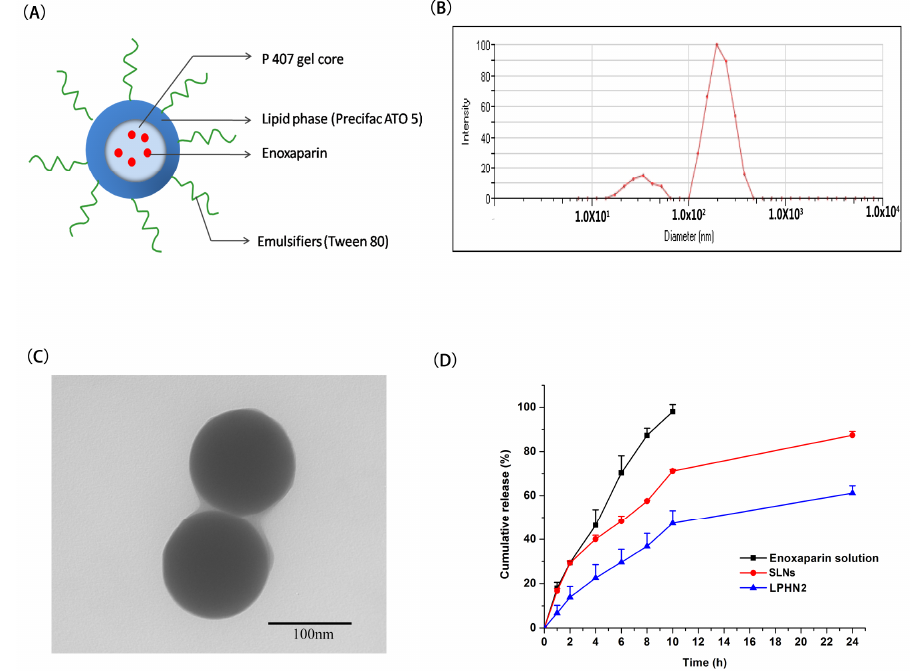
Figure 1. ( A ) Schematic representation of the structure of enoxaparin-loaded lipid hybrid nanoparticles. ( B ) The size distribution of lipid–polymer hybrid nanoparticle 2 (LPHN2). ( C ) The transmission electron microscopy (TEM) morphology of LPHN2. ( D ) In vitro release of profiles of enoxaparin from enoxaparin solution, enoxaparin-loaded solid lipid nanoparticles (SLNs), and enoxaparin-loaded LPHN2 ( n = 3). Table 1. Characterization of enoxaparin-loaded lipid-polymer hybrid nanoparticles at 3 different ratios of poloxamer 407 ( n = 3).